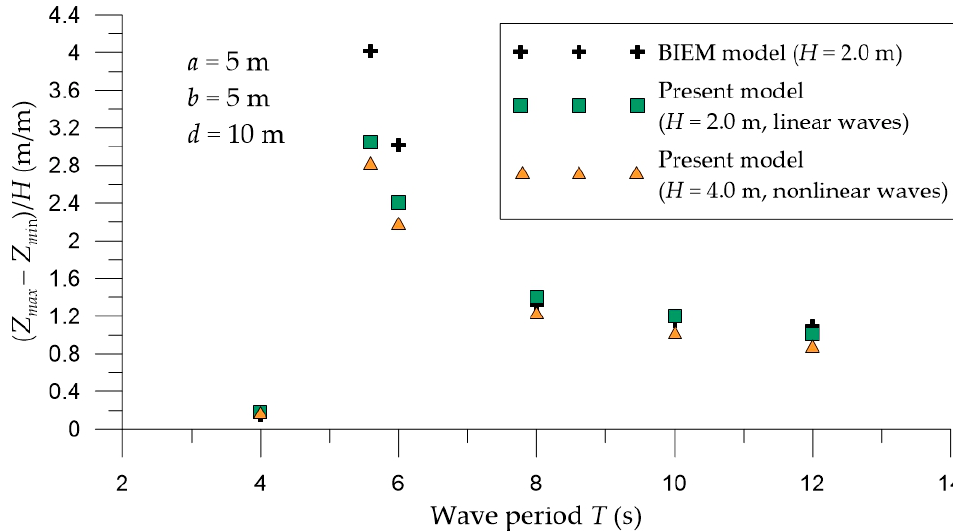
Figure 8. Nondimensional vertical displacement of a cylinder with a = 5.0 m and b / a = 1.0 ( d = 10.0 m) under linear and nonlinear monochromatic waves.